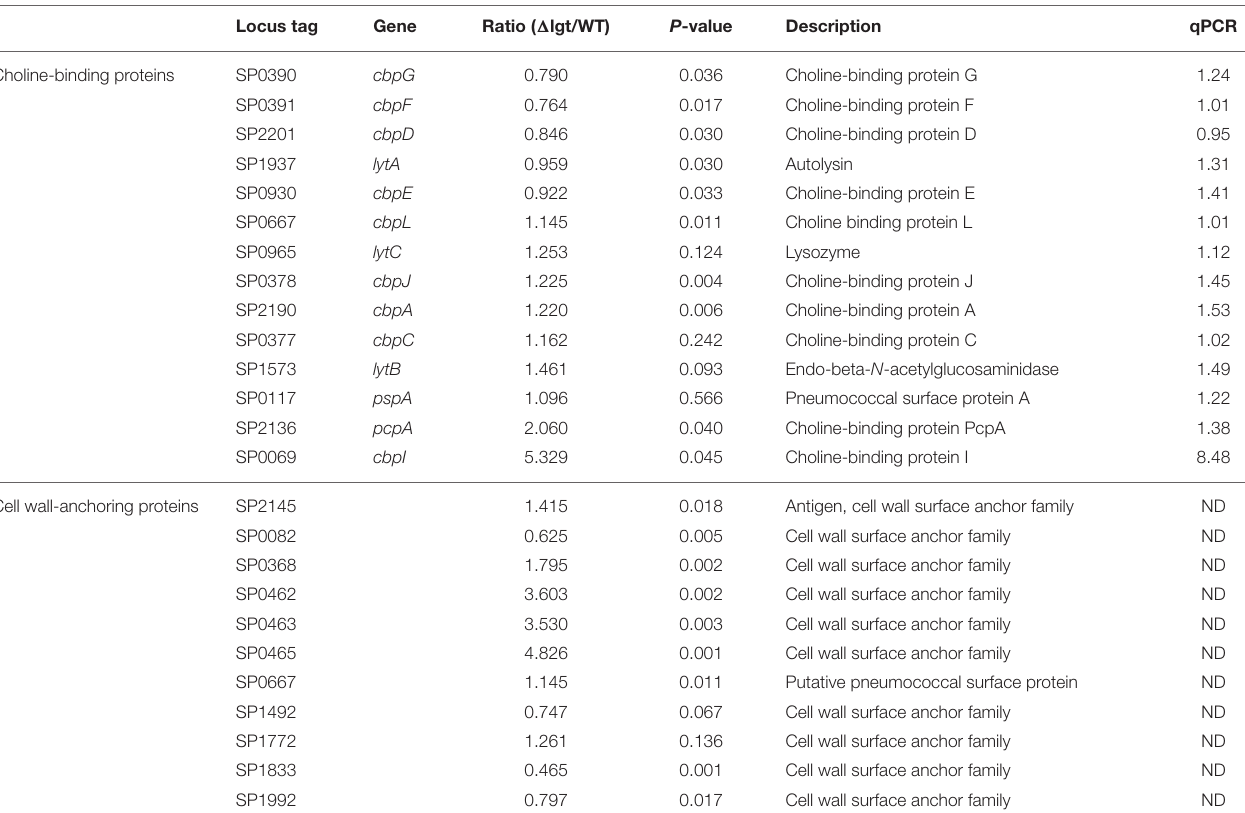
TABLE 2 | Expression of choline-binding protein members and cell wall-anchoring protein genes in wild-type TIGR4 and TIGR4 1 lgt pneumococci. Locus